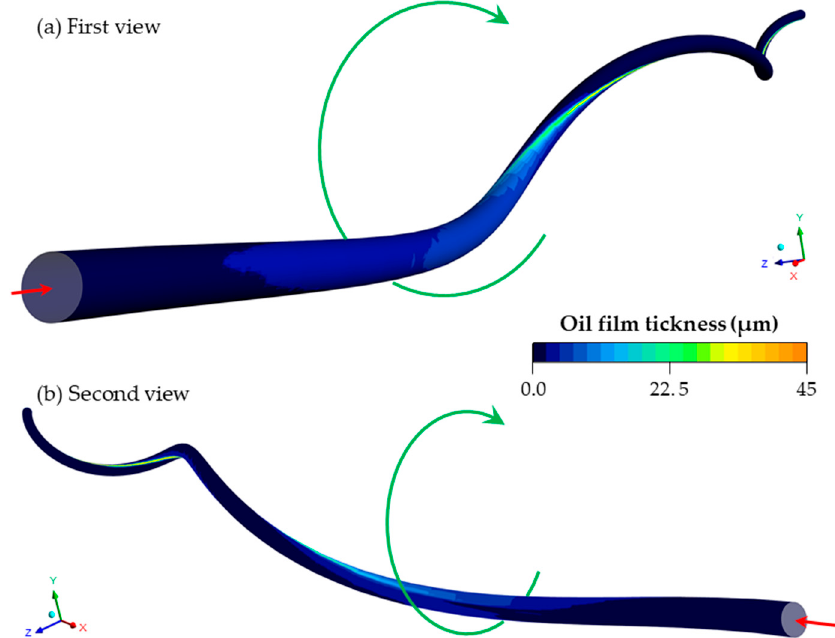
Figure 4. Color plot of oil film thickness along the internal channel wall obtained under conditions of zero drill bit rotational speed and oil droplet diameter and flow rate at the inlet section of 2 µm and 5 mL/h, respectively. The red arrow indicates the flow direction at the microchannel inlet, while the green arrow indicates the rotation direction of the drill bit.